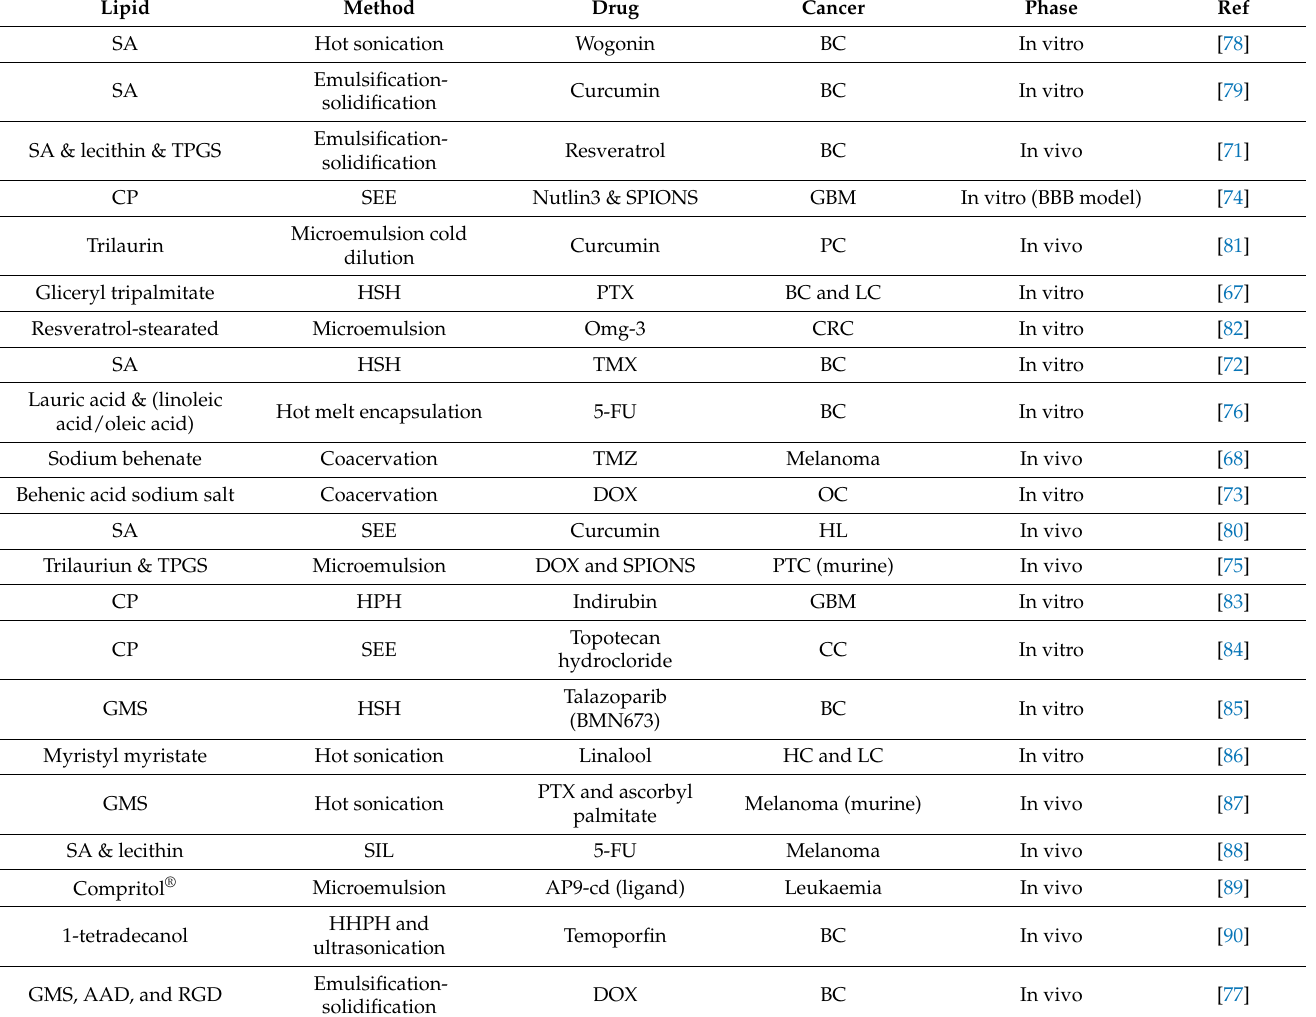
Table 3. Examples of SLNs formulation for cancer treatment in different stages of